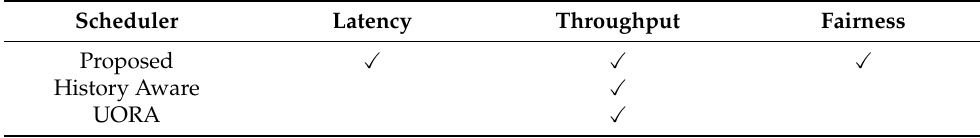
Table 2. Comparison of the proposed algorithm with the state of the art. Scheduler Latency Throughput Fairness